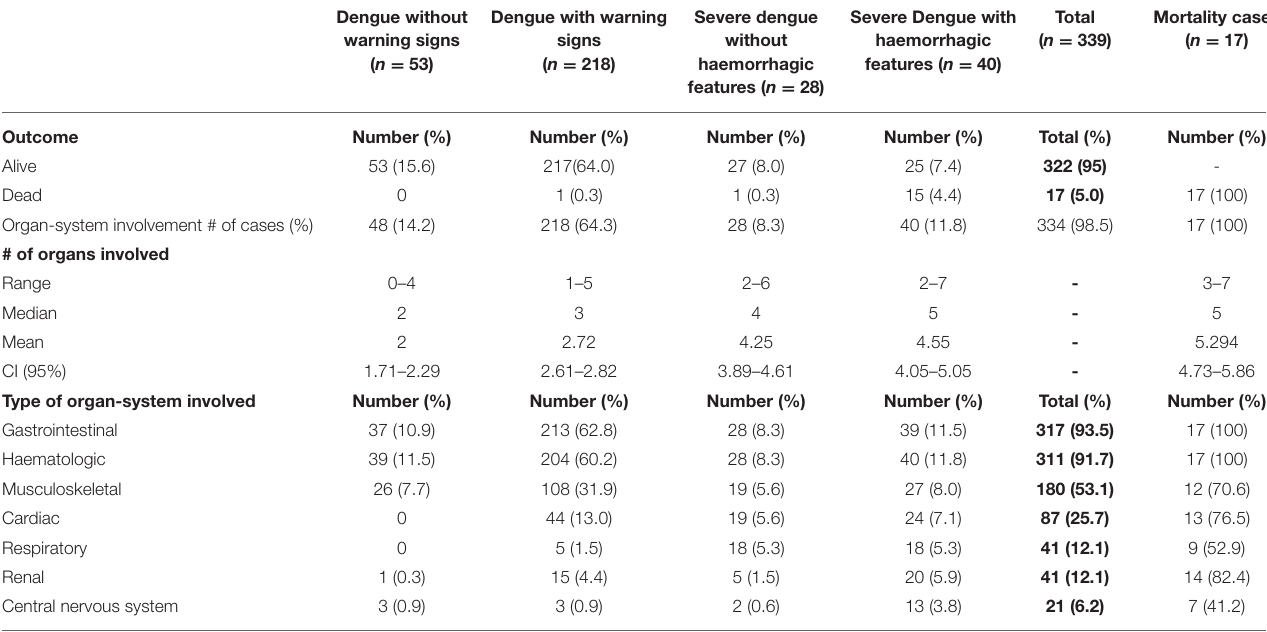
TABLE 4 | Organ-system involvement in pediatric patients hospitalized with suspected dengue in 2018–2019 epidemic.